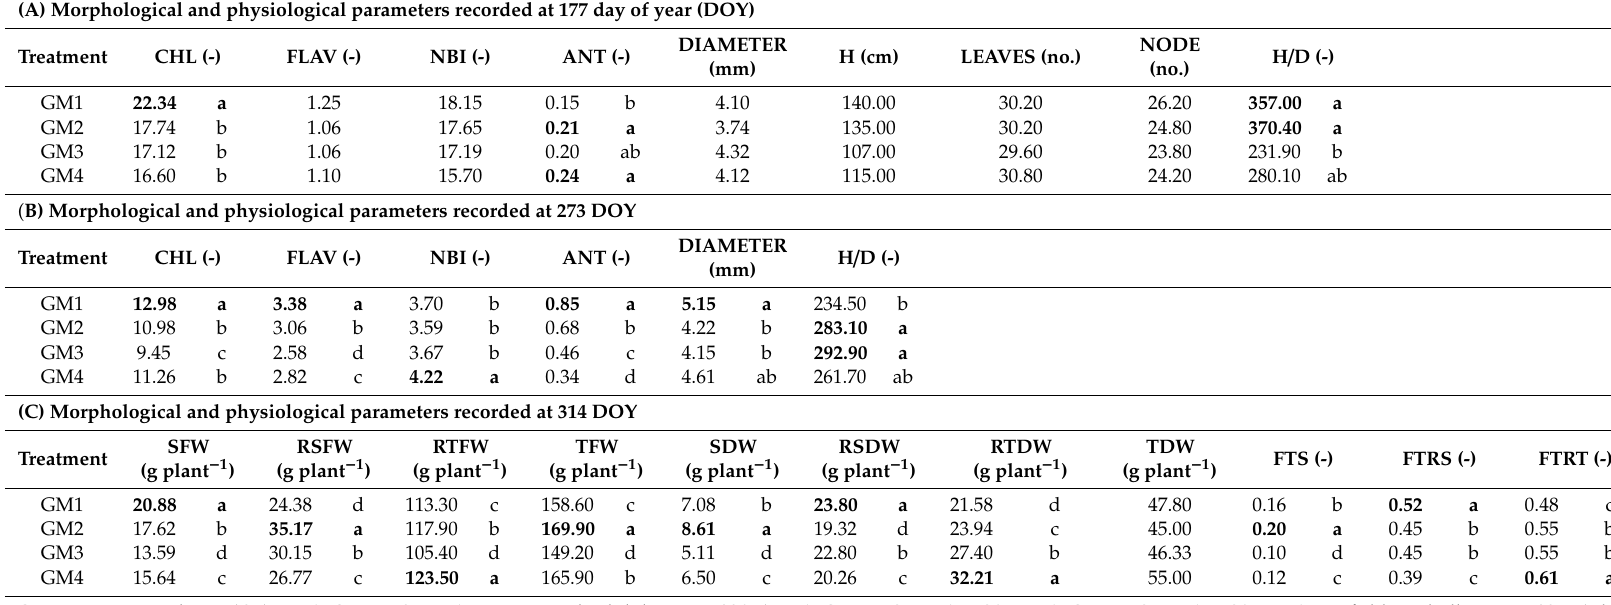
Table 4. Parameters assessed on greenhouse bench-grafts grown on growing media containing composted solid